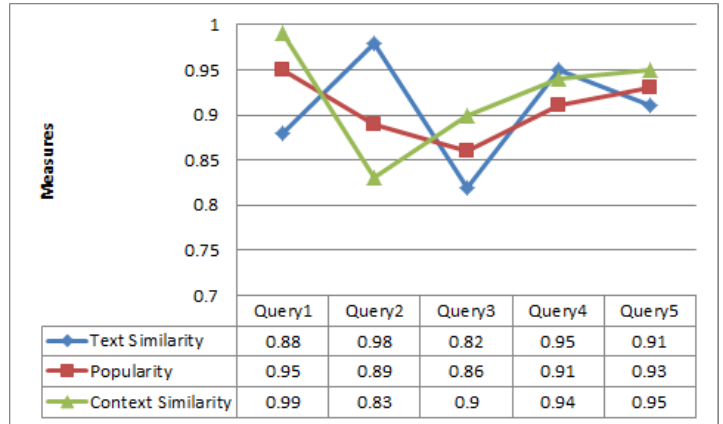
Figure 3. Component retrieval